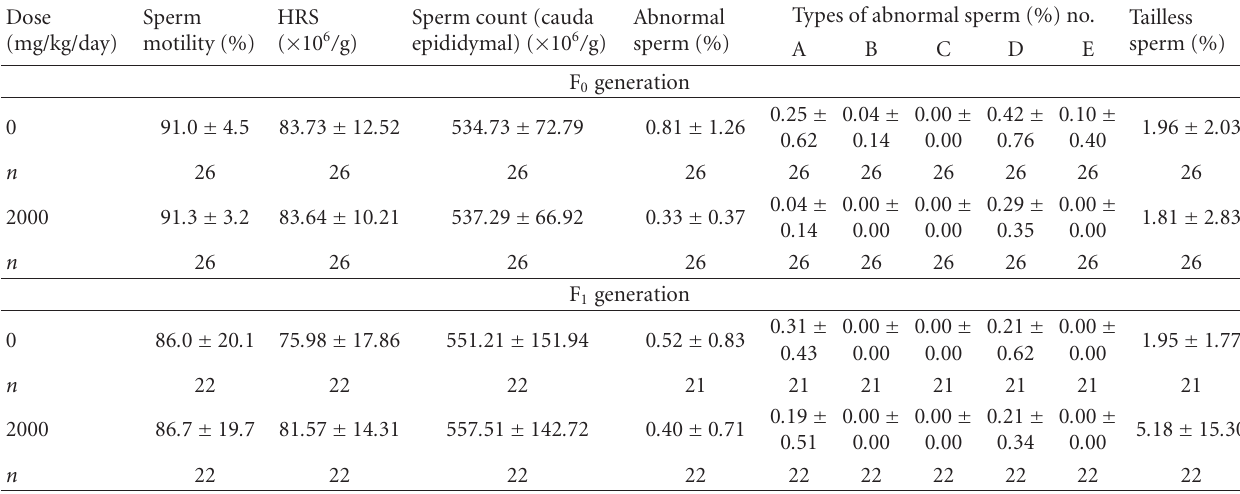
Table 9: Sperm parameters in control and high-dose male rats used as breeding males in the F 0 and F 1 two-generation reproduction study. Dose